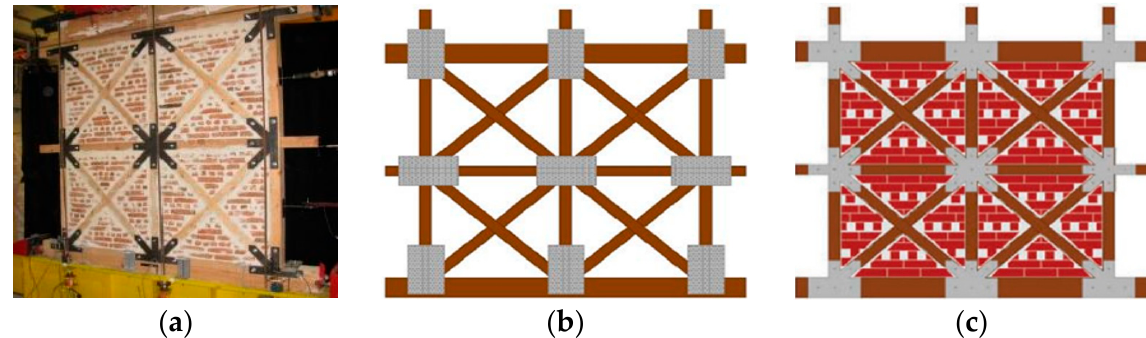
Figure 14. Strengthened timber frame wall with ( a ) steel plates [105], ( b ) steel plate without masonry infill, and ( c ) with masonry infill [108].